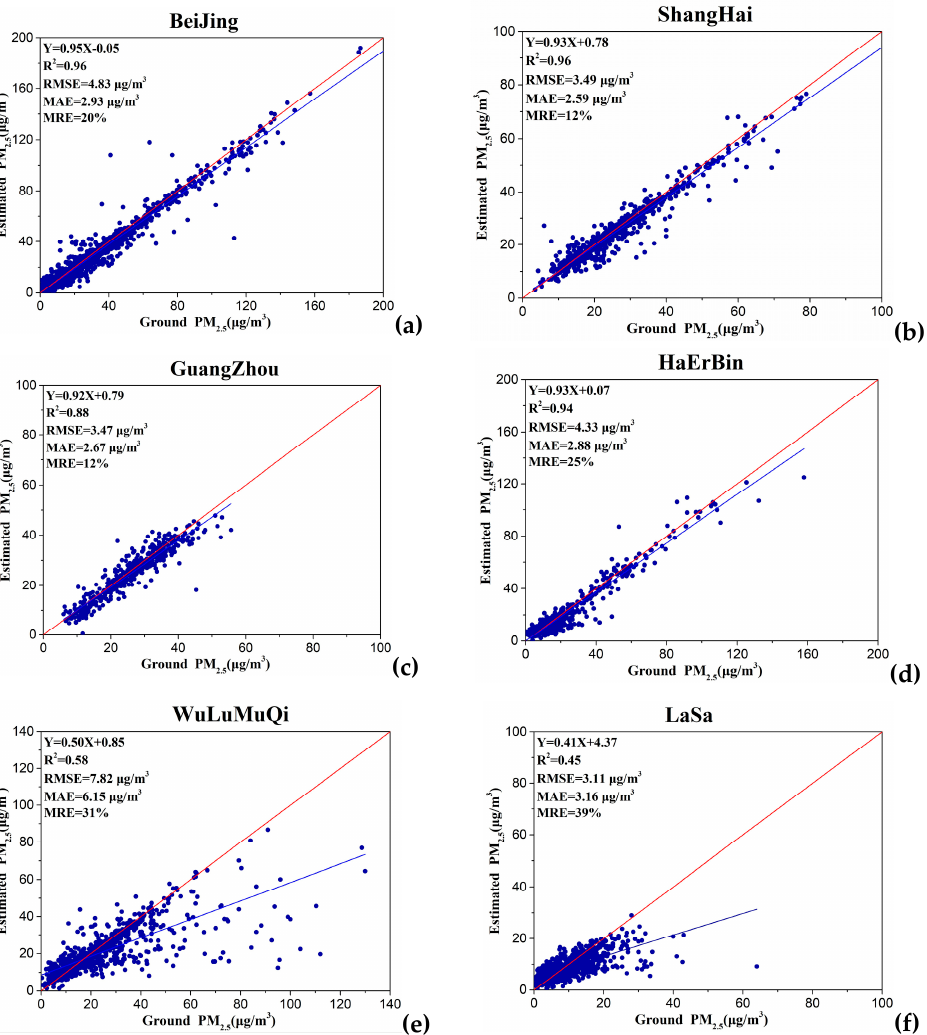
Figure 9. Scatter plot of model results for typical cities. ( a )—Beijing, ( b )—Shanghai, ( c )—Guangzhou, ( d )—Ha’erbin, ( e )—Wulumuqi, and ( f )—Lasa. The blue and red lines denote the linear regression and 1:1 line,